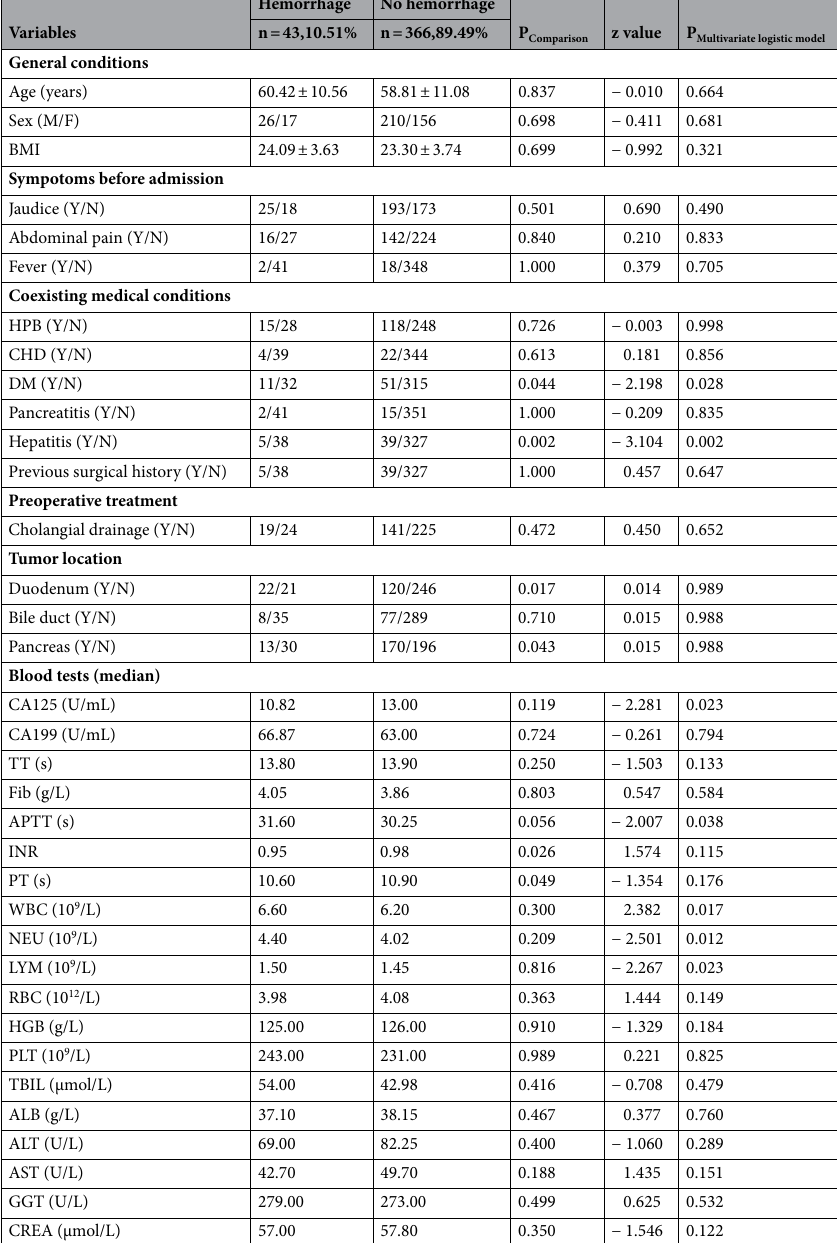
Table 1. The statistical characteristics of the perioperative data in the training cohort. P Comparison : P value of the statistical comparison between the hemorrhage group and no hemorrhage group; z value: The multivariate logistic regression analysis was performed to develop a full-variable logistic model. P Multivariate analysis : P value of the multivariate logistic regression analysis of the risk-associated factors of postoperative hemorrhage. BMI body mass index, HPB high blood pressure, CHD coronary heart disease, DM diabetes